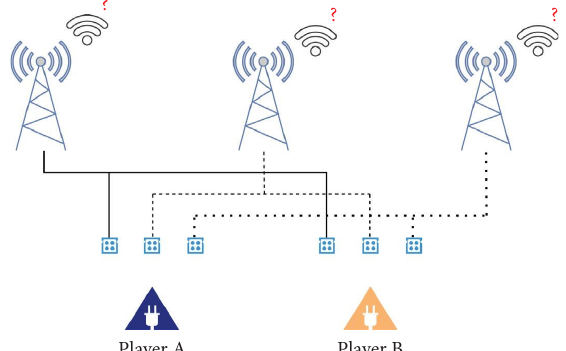
Figure 1: Internet connection through relays. Each player makes a probabilistic decision about which bandwidth to connect; however, when both select the same bandwidth, the line is shared, and there is a decrease in the transmission